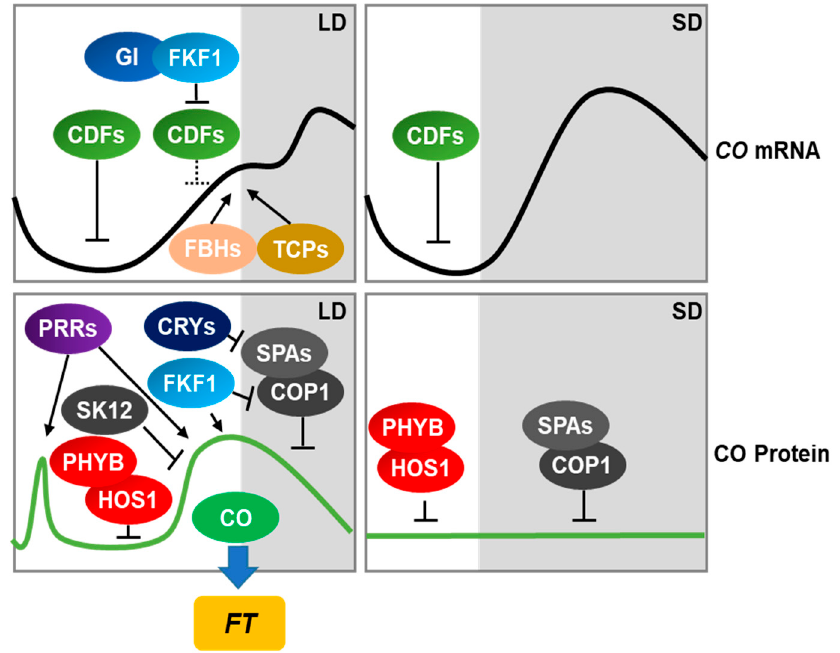
Figure 1. Photoperiodic regulation of FT expression is mediated by CO in Arabidopsis. Photoperiodic flowering in Arabidopsis is primarily mediated by transcriptional and posttranslational regulation of the transcription factor gene CONSTANS ( CO ). Under inductive long-day conditions, the CYCLING DOF FACTOR (CDF)-dependent repression of CO expression is diminished by the blue light-dependent FKF1-GI complex. FBHs and TCPs then induce CO expression. CO protein stability is further regulated by PHYB, SK12, PRRs, FKF1, CRYs, COP1, and SPAs. PHYB mediates red light dependent CO destabilization. SK12 interacts with CO and phosphorylate it for destabilization. During the night, CO is degraded by the COP1-SPAs complex. This COP1-SPA-dependent CO degradation is inhibited by FKF1 and COP1 in the presence of blue light. In addition, the circadian clock component PRRs interact with and stabilize CO. Once CO has been stabilized in the afternoon, it activates the transcription of FT , which in turn induces flowering. Under non-inductive short-day conditions, CDFs continuously repress the transcription of CO during the day. In addition, the PHYB-HOS1 and COP1-SPAs complexes inhibit CO accumulation, thereby preventing flowering under short-day conditions.